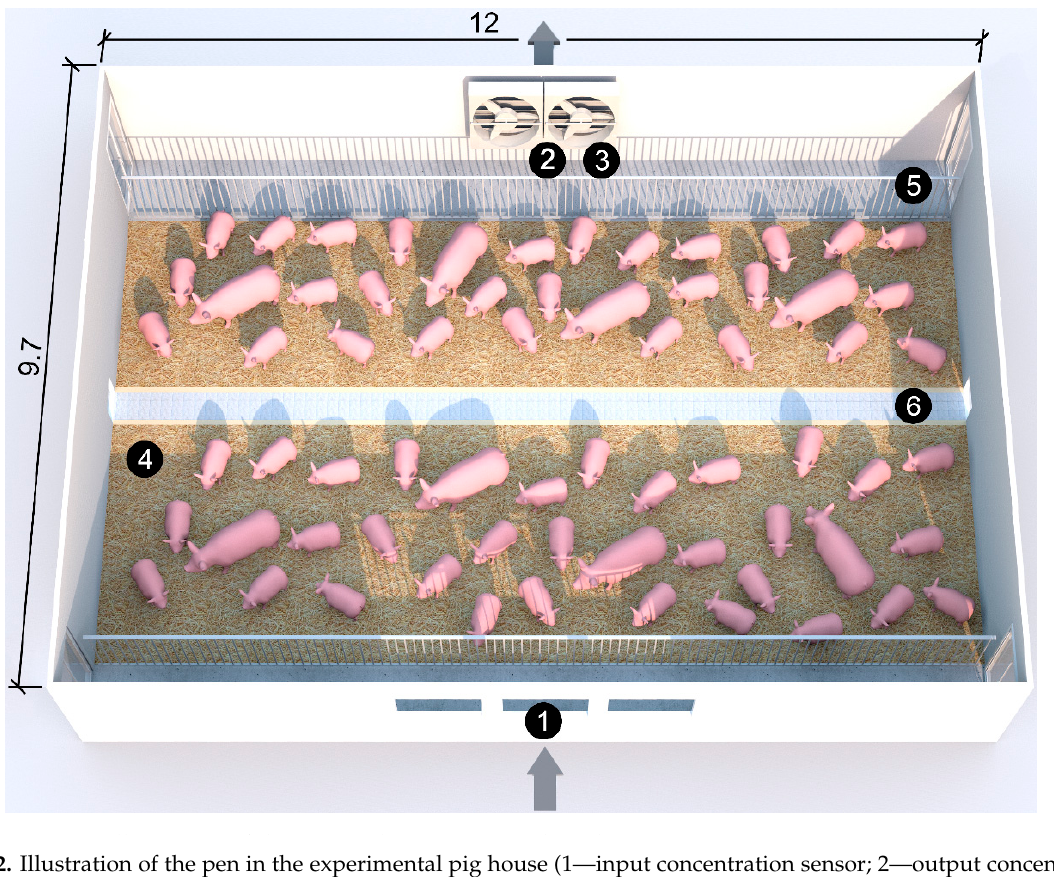
Figure 2. Illustration of the pen in the experimental pig house (1—input concentration sensor; 2—output concentration sensor; 3—anemometer for air velocity measurement; 4—deep straw litter; 5—service alleyway, 6—manure corridor).